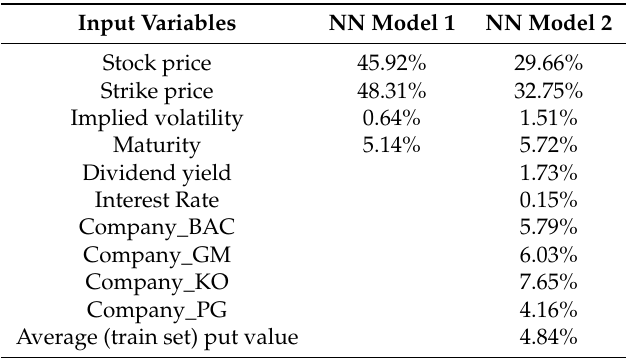
Table 9. Inputs’ relative